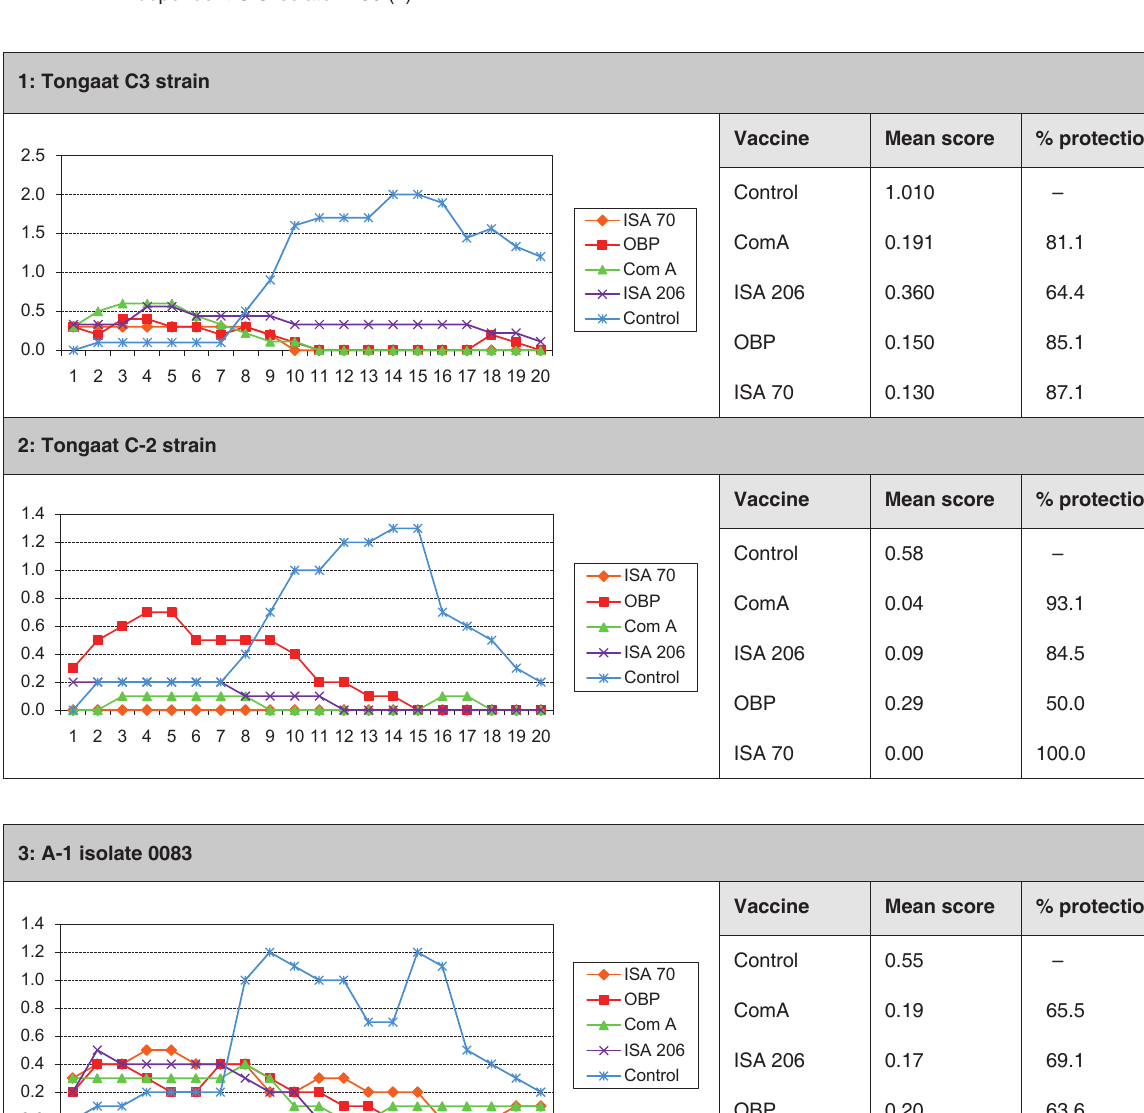
TABLE 3A First vaccination: Graphic representation of the mean daily disease scores obtained from each of the vaccines for chick- ens challenged with different A. paragallinarum challenge strains and table summarizing the corresponding mean lesion score and percentage protection—the Tongaat (C-3) strain (1); C-2 strain (2); the A-1 isolate 0083 (3); and the NAD- independent C-3 isolate 1750